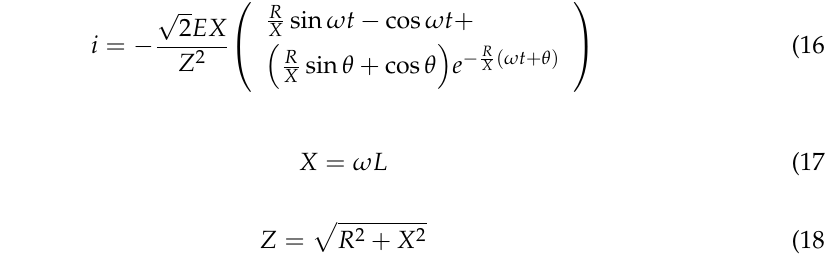
Figure 7. Voltage, flux, current and resistance of a superconducting winding.